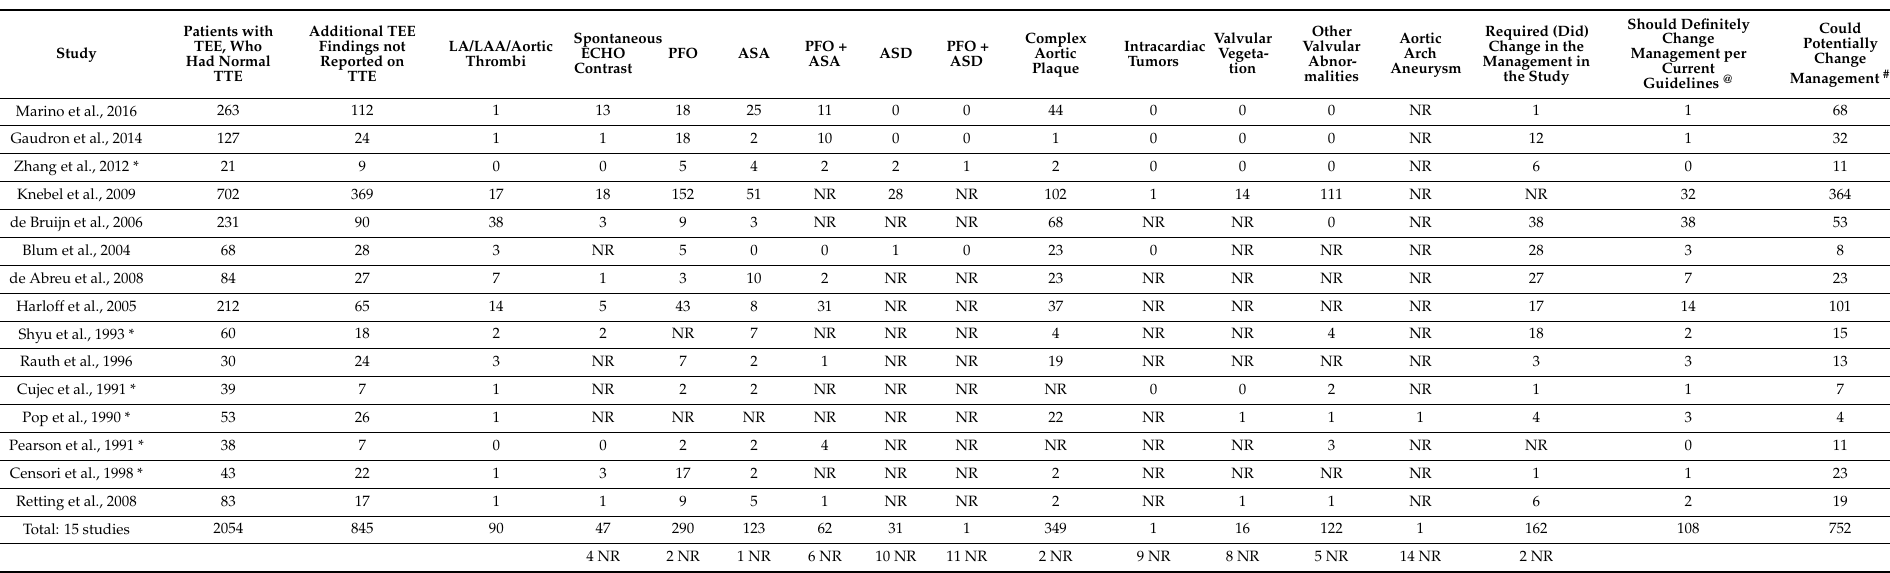
Table 2. Studies showing cardiac abnormalities found on TEE that did change, should change, or could potentially change the management of CS/TIA patients after TEE evaluation. Patientswith TEE,Who Study HadNormal